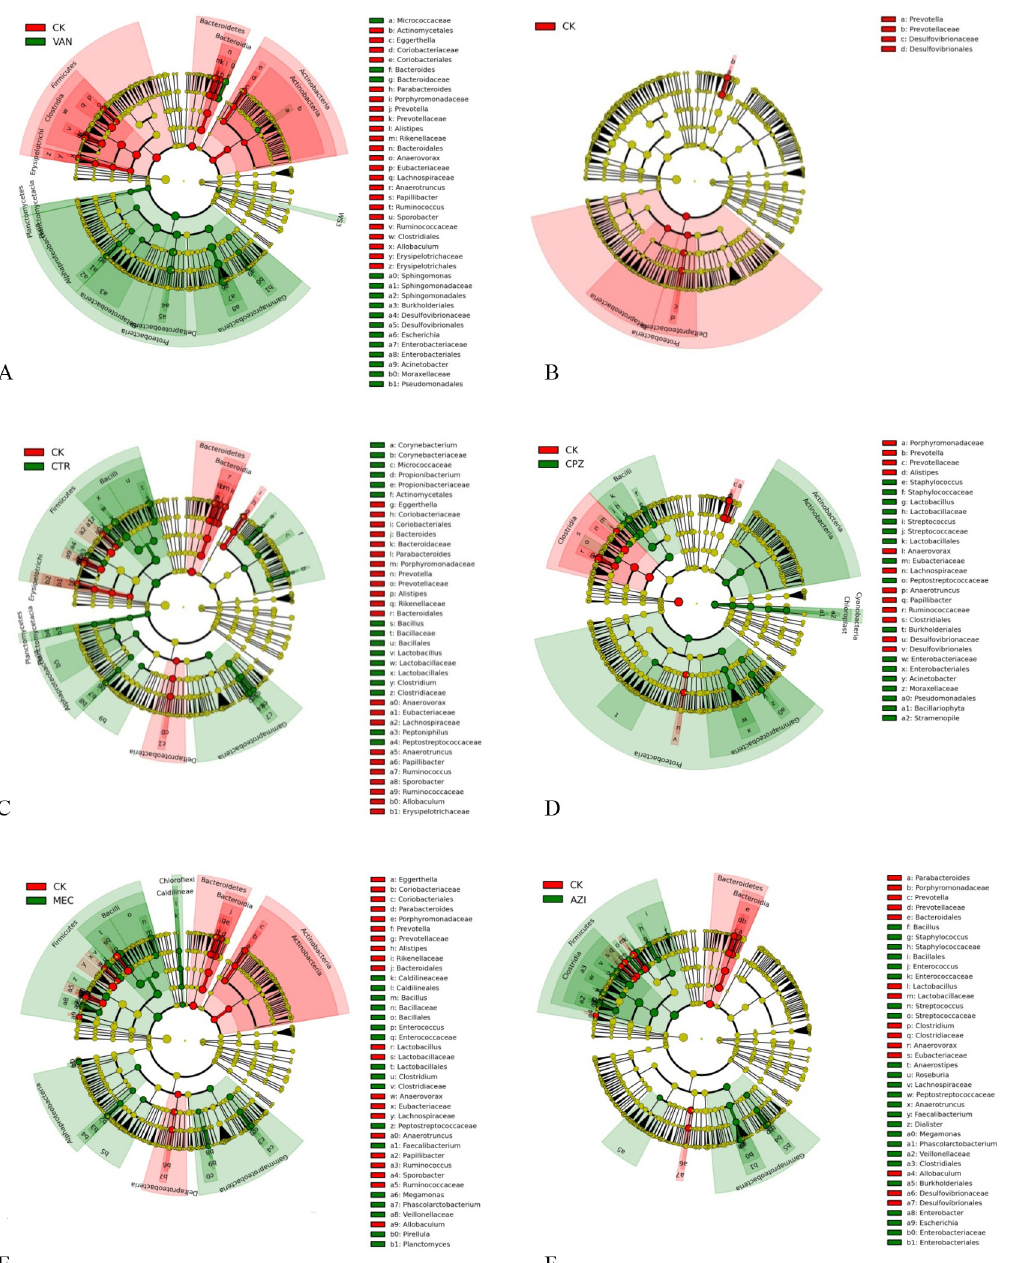
Fig 5. LEfSe comparison chart of control and antibiotic groups during antibiotic administration. A. VAN, B. OFL, C. CTR, D. CPZ, E. MEC and F. AZI.